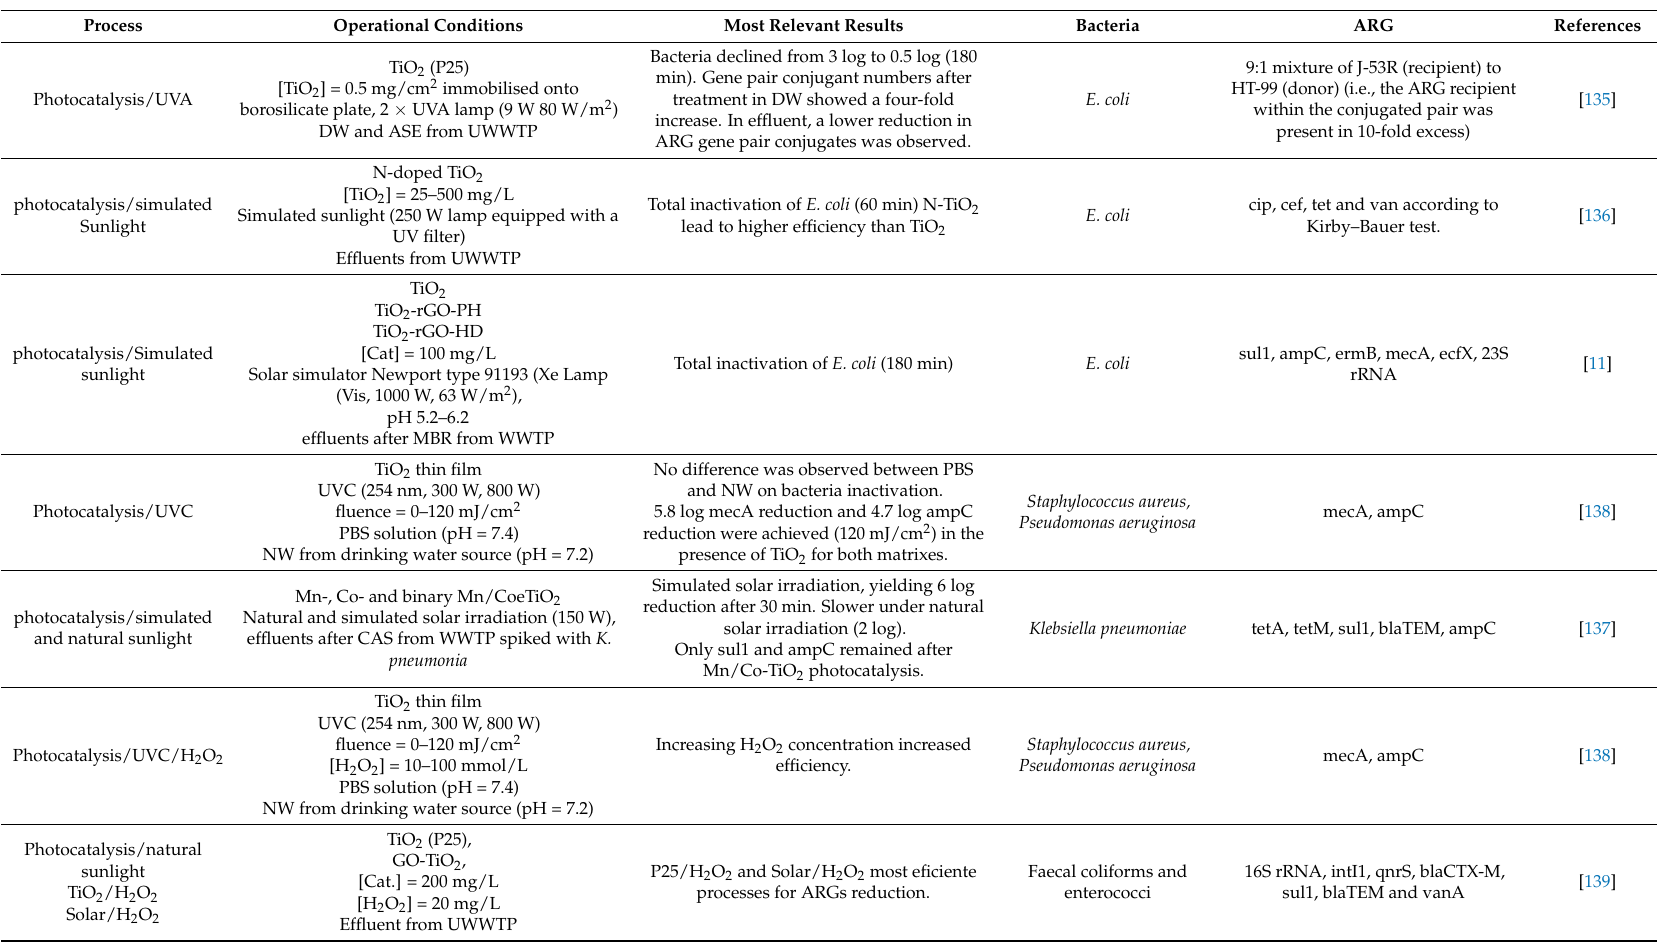
Table 3. Application of heterogeneous photocatalytic processes for water